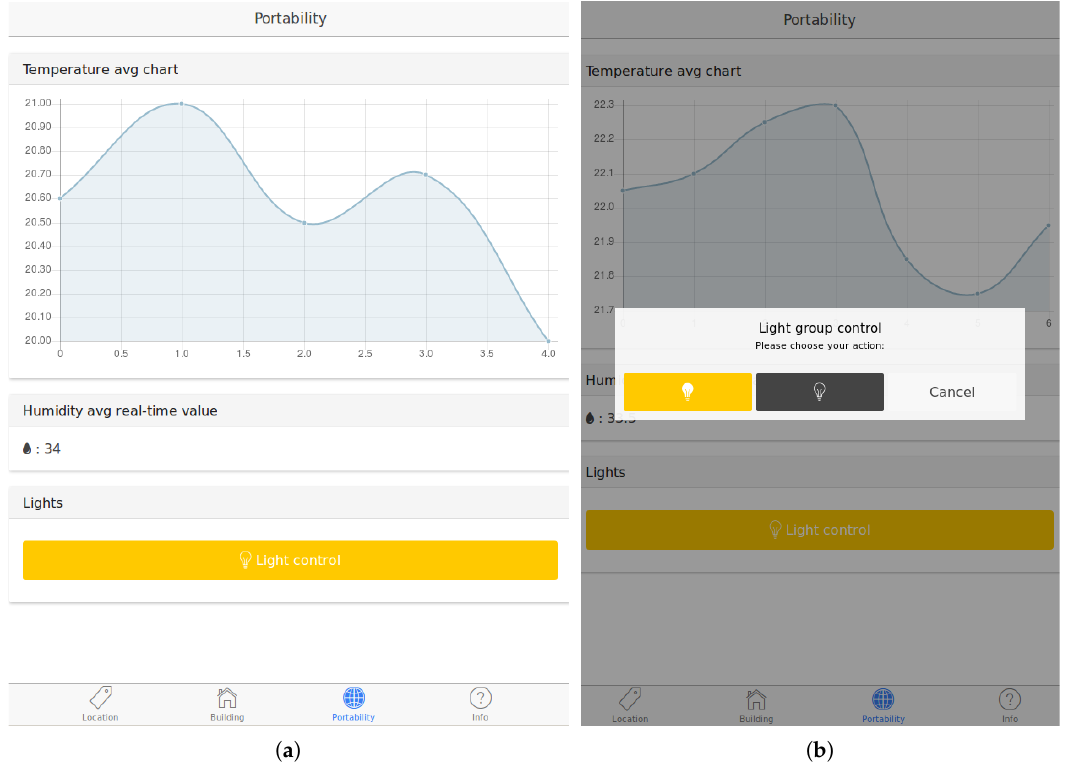
Figure 7. User application screenshots with some defined behaviours defined in the PoCo. ( a ) A chart, real-time values and a group of lights; ( b ) Pop-up window for interact with a light